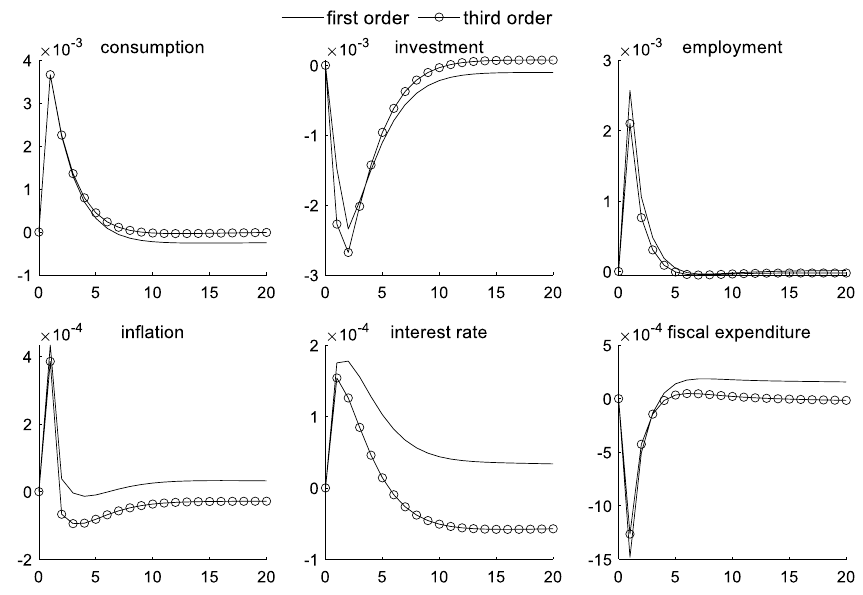
Fig. 3 Macroeconomic effects of risk preference shock under sudden